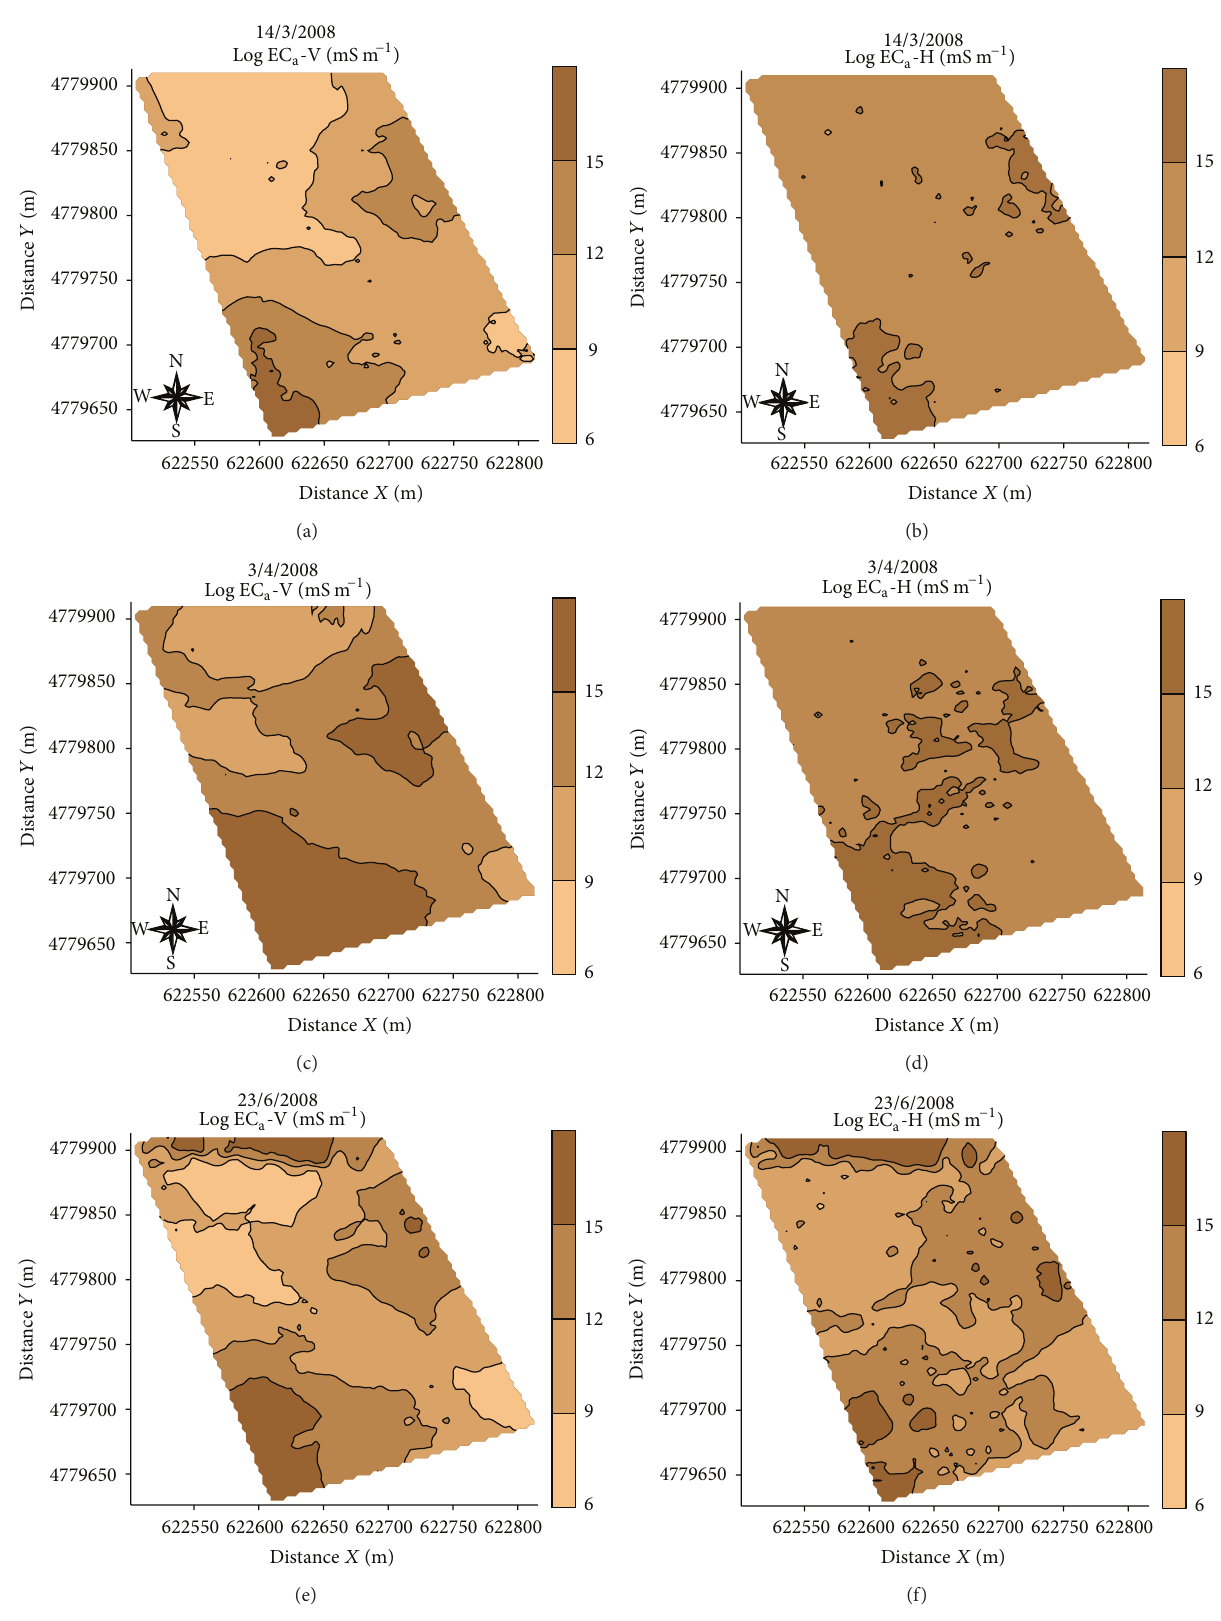
Figure 5: Kriging maps of apparent soil electrical conductivity (EC and